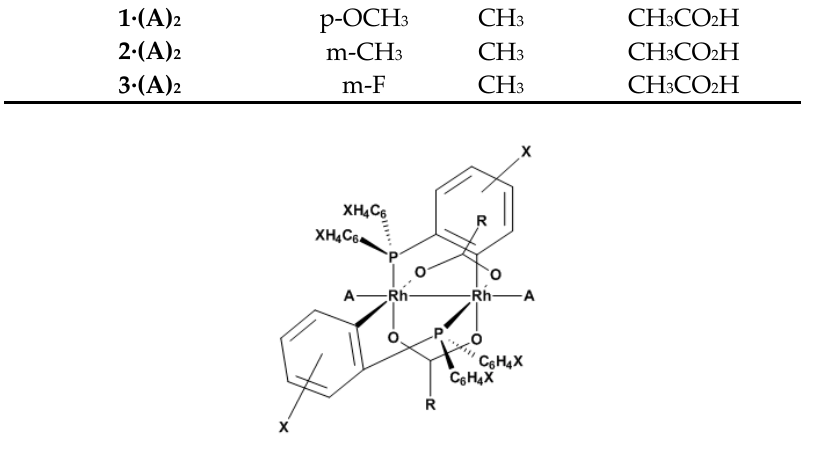
Figure 1. Chemical structure of the colorimetric binuclear rhodium complex Rh 2 (O 2 CCH 3 ) 2 (P(C 6 H 4 X) 3 ) 2 ∙ A 2 with different ligands (see Table 1). 0.45 mmol (200 mg) rhodium acetate dimer were dissolved in a mixture of 25 mL toluene